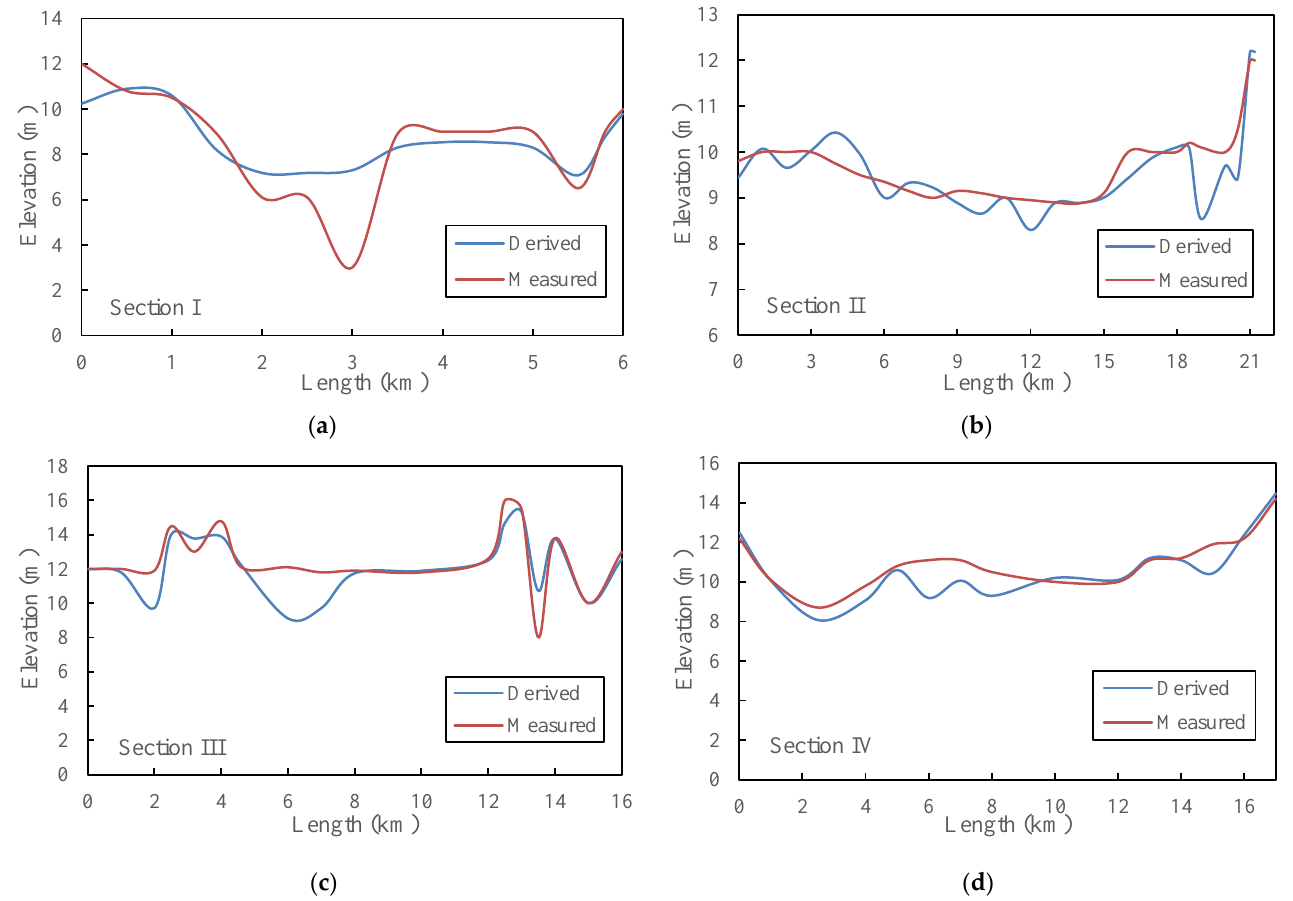
Figure 10. Comparisons between the measured and derived topographic data of Sections I to IV: The black line is the 1:1 line. N is the total number of the measured points.